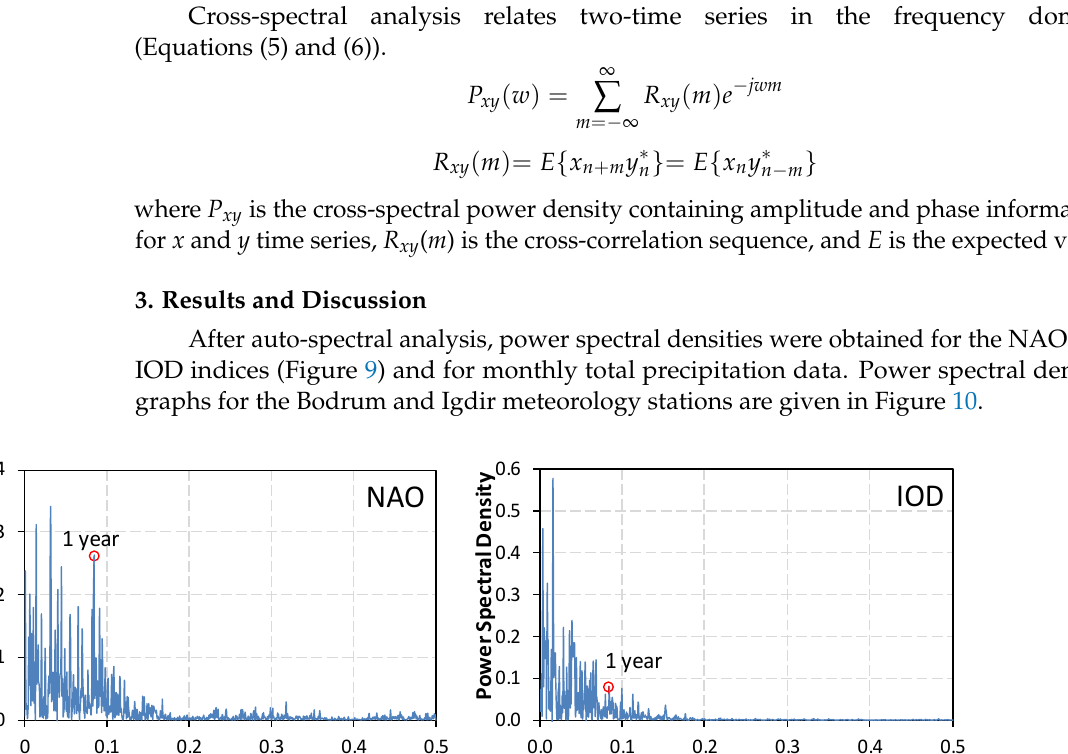
0.00.10.20.30.4 Figure 9. Auto-spectral analysis results for the monthly North Atlantic oscillation (NAO) and IOD indices. Figure 10. Auto-spectral analysis results for monthly total precipitation at Bodrum and Igdir stations.